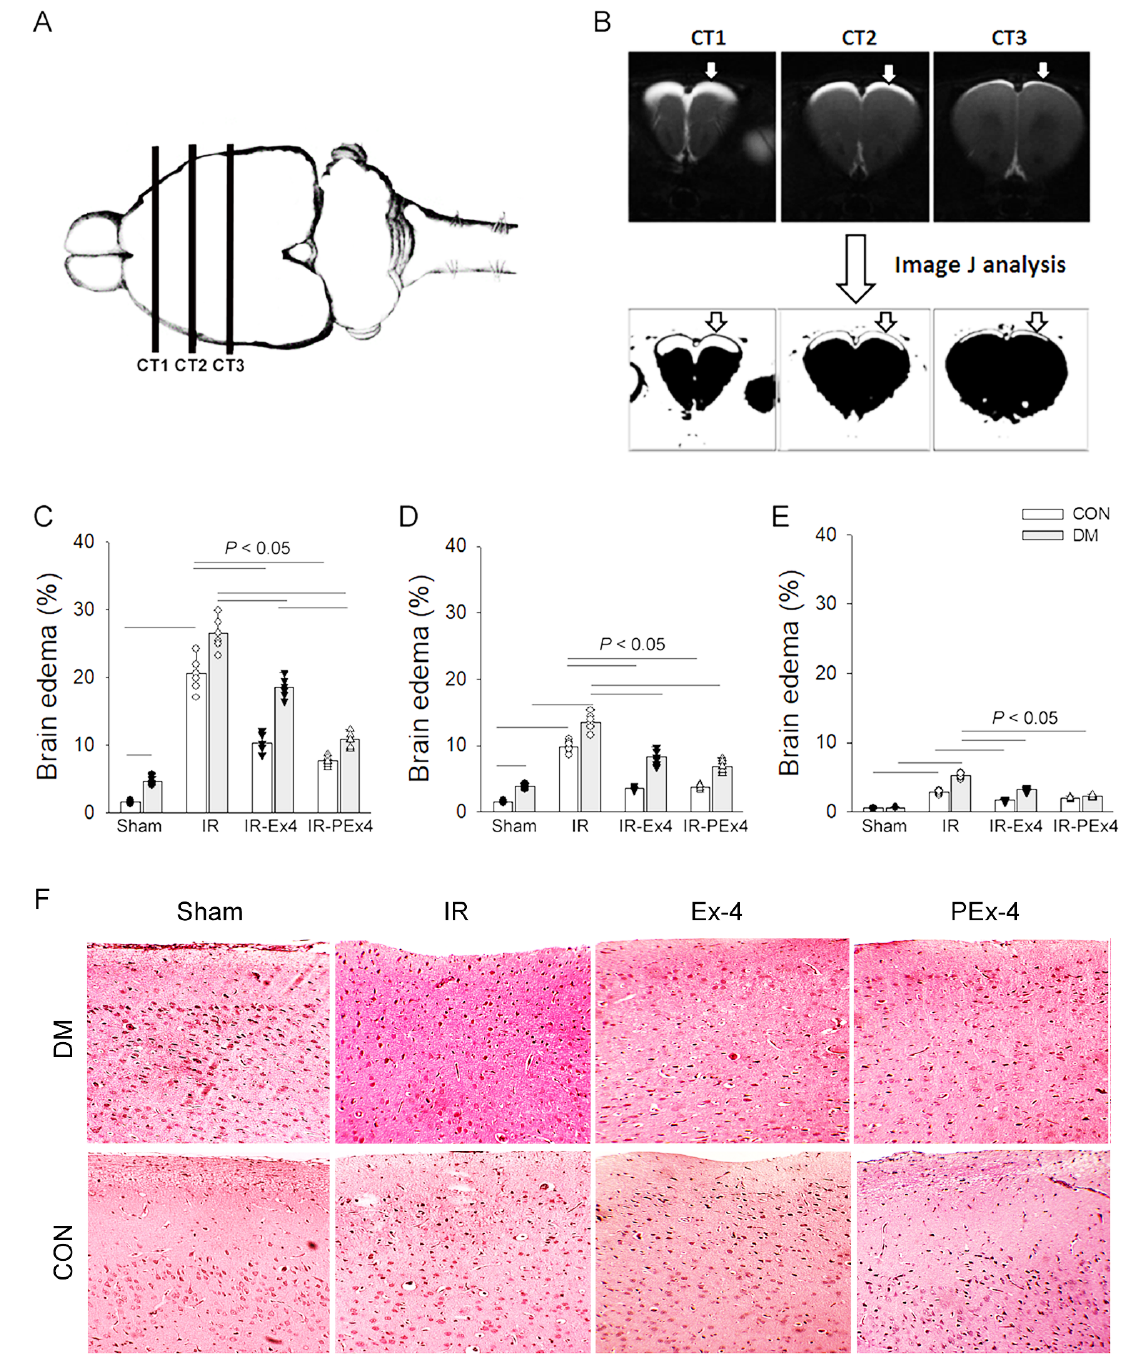
Figure 3. The panel shows three caudo-rostral projections (CT1, CT2 and CT3) of coronal sections through a rat brain ( A ). The bright zones on T2-weighted images represent 24 h after IR-induced brain edema and are analyzed with ImageJ software ( B ). The percentage (%) of the brain edema zones increased after 24 h of IR and significantly decreased with the pretreatment of Ex-4 (IR-Ex4) or PEx-4 (IR-PEx4) in CT1 ( C ), CT2 ( D ) and CT3 ( E ) sections in both control and DM rat brain coronal sections. The paralleled histologic evidence of CT1 section from eight groups of brain is displayed ( F ). Data are expressed as mean ± SEM in each group ( n = 6) using the single values. The statistical difference is indicated by the horizontal line with p < 0.05 between groups using one-way ANOVA, followed by Bonferroni’s post hoc test. Each symbol represents one sample in different